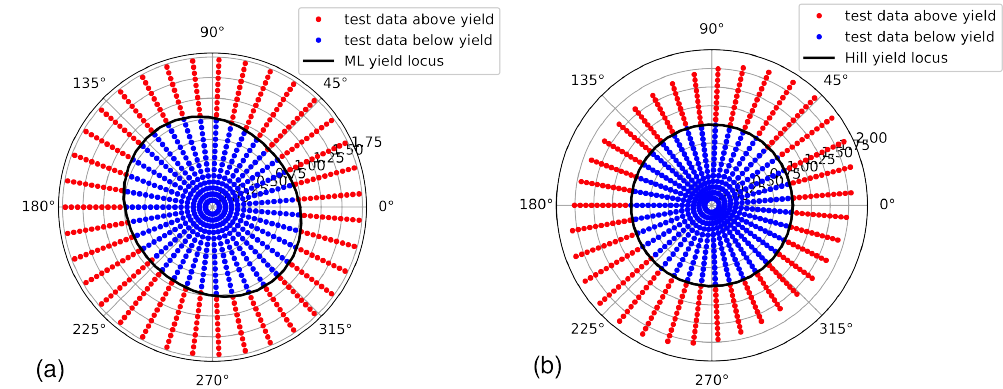
Figure 2. Polar plots of a subset of the training data produced from the anisotropic yield function of the reference material: ( a ) Von Mises (J2) equivalent stresses according to Equation (3) are used, such that the yield strength, rather than the equivalent stress, is a function of the polar angle θ . ( b ) Equivalent stresses are calculated according to the Hill definition in Equation (5) to achieve a constant yield strength by mapping the equivalent stresses accordingly. In both figures, the yield locus is indicated by a solid black line, data points in the elastic regime are plotted in blue color and data in the plastic regime in red color. Both figures represent the same stress data, only mapped in a different way; all stresses are normalized with the reference yield strength σ y .